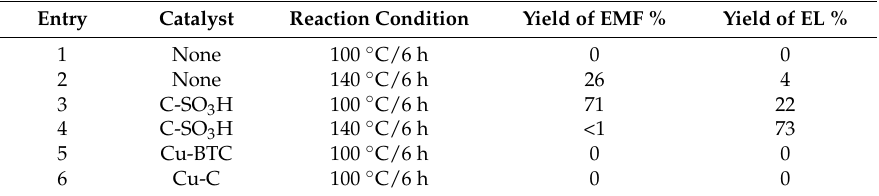
Table 1. Synthesis of EMF and EL from HMF catalyzed in different reaction conditions.